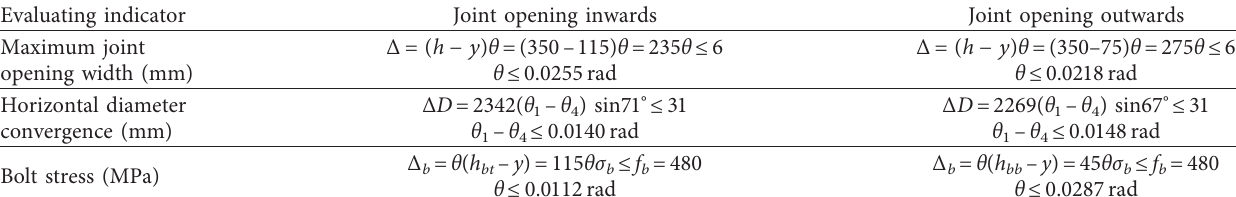
Table 1: Limits of the joint opening angle.